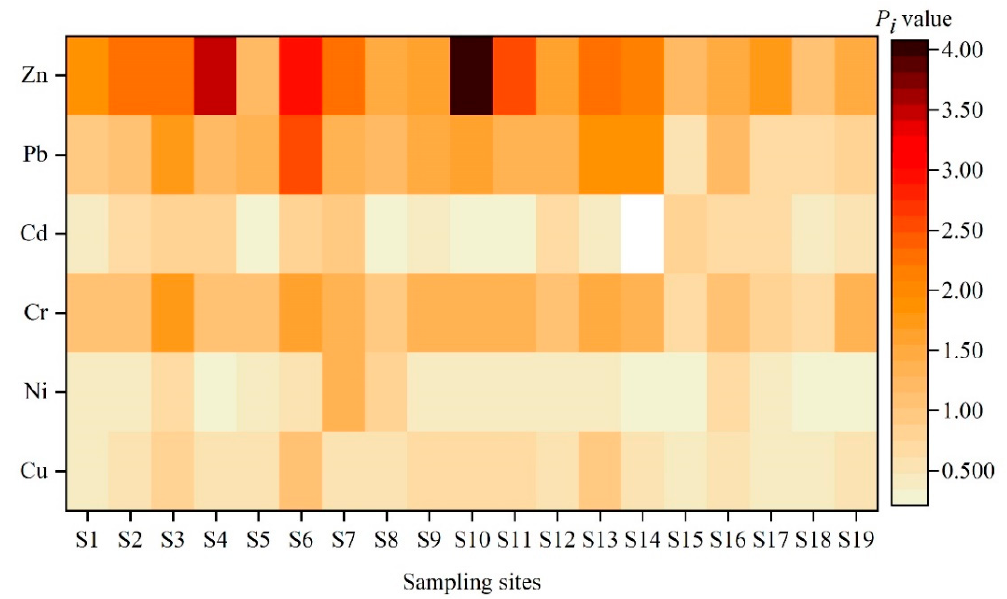
Figure 4. Heat map of Cu, Cr, Pb, Ni, Cd, and Zn in snow cover by single-element pollution index ( P i , Equation (1)).